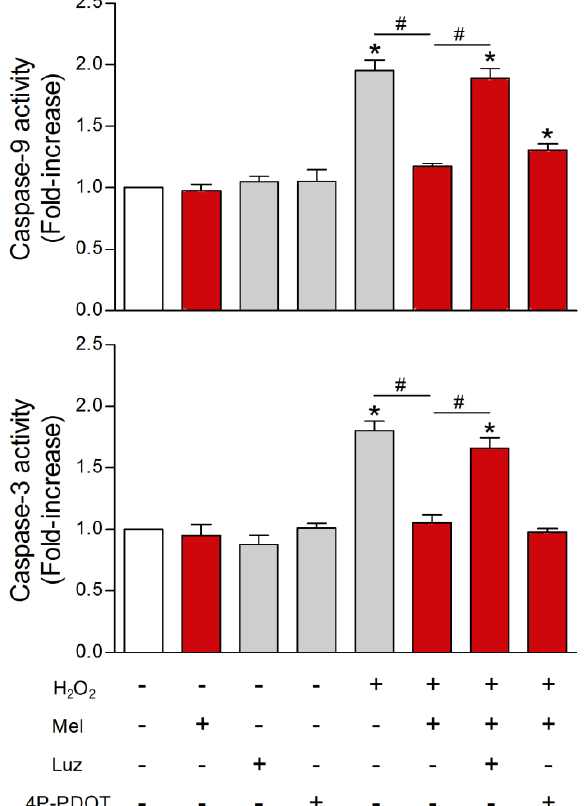
Figure 10. Evidence that the melatonin membrane receptor, MT1, is involved in the protective actions against H O toxicity in human spermatozoa. Both the activity of 2 2 caspase 9 (top panel) and caspase 3 (bottom panel), changes that are indicative of pending apoptosis, were elevated when the sperm were exposed to H O . These increases were 2 2 blocked when luzindole (Luz), an MT1 and MT2 receptor antagonist, was added to the incubation medium but not when the selective MT2 blocker, 4P-PDOT, was added. These findings are consistent with the MT1 receptor mediating, at least in part, the ability of melatonin to defer H O -induced apoptotic processes in human spermatozoa. * p < 0.05, 2 2 compared with all other values; # p < 0.05. From Espino et al.